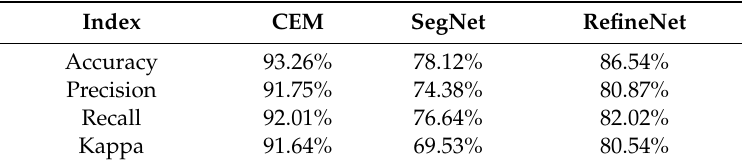
Table 7. Comparison of the performance of the three